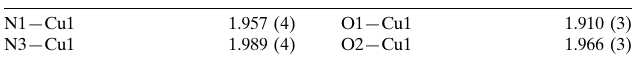
Selected bond lengths (A˚